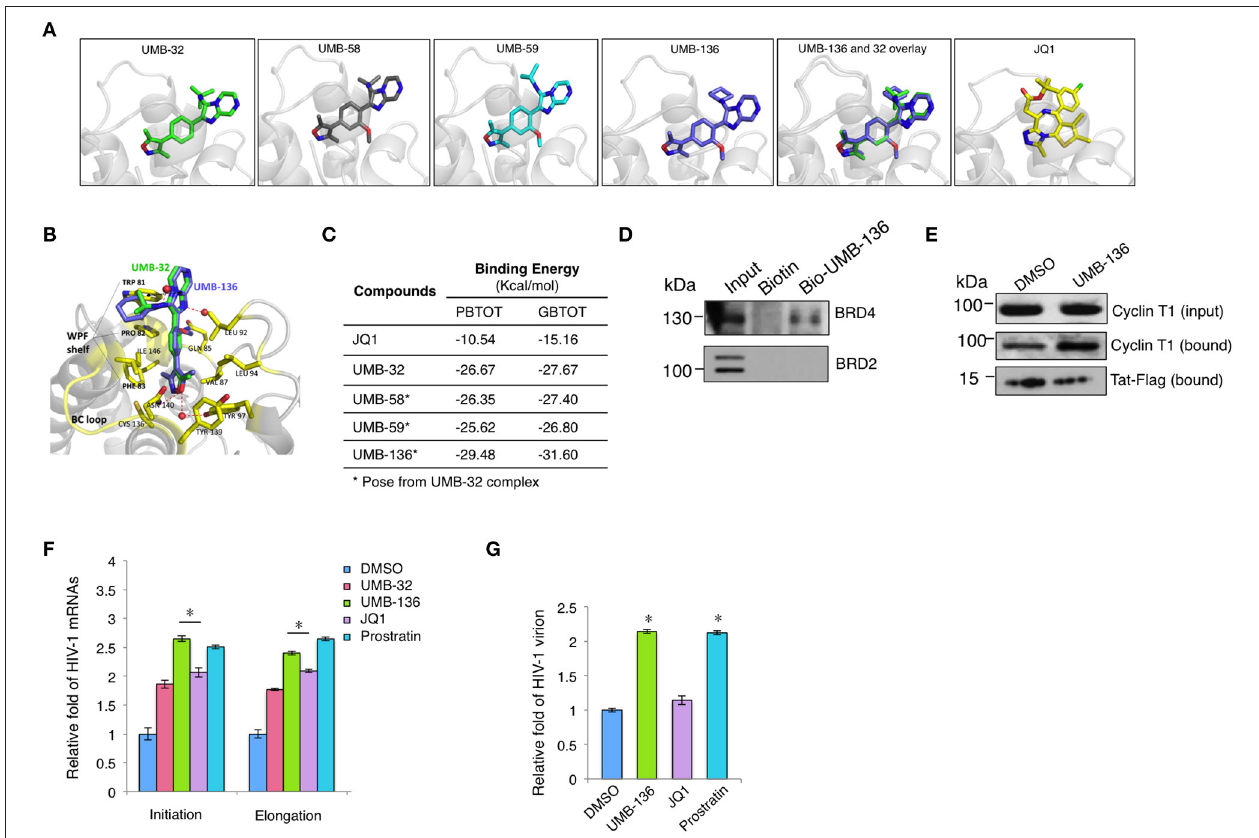
FIGURE 2 | UMB-136 promotes HIV-1replication by releasing P-TEFb through binding to BRD4. (A) The predicted binding of UMB-58, 59, and 136 with the BRD4 bromodomain (BD1) according to the available data for UMB-32. (B) The superimposition of UMB-136 (violet) onto UMB-32 (green) in complex of BRD4 BD1 (PDB ID: 4WIV; protein: residues in contact with ligand shown in yellow, the rest in gray); hydrogen bonding with crystal waters (red spheres) in dashed red lines, pi-stacking in black dashed line. Graphic representations of (A,B) are generated in PyMol Software. (C) Calculation of the binding energy (PBTOT—relative total binding energy using MM-PBSA; GBTOT—relative total binding energy using MM-GBSA) for UMB-32, 58, 59, 136, and JQ1. (D) Pull-down assay for UMB-136. The lysate of HEK293 cells was incubated with biotinylated UMB-136 or biotin in DMSO at 4 ◦ C for overnight with orbital rocking. MyOne TM Streptavidin T1 Dynabeads TM (Invitrogen) were added to the mixture for incubation for 2 h. Beads were washed and boiled to elute the precipitated proteins and subjected to immunoblotting using BRD4 or BRD2 antibody. (E) UMB-136 promotes the association of Tat and P-TEFb. Hela cells stably expressing Tat-Flag were treated with UMB-136 (2.5 µ M) or DMSO for 24 h, followed by the incubation with Magnetic Flag Conjugated beads (Clontch) at 4 ◦ C for overnight. Beads were washed and boiled to elute the precipitated proteins, which were subjected to immunoblotting using Cyclin T1 antibody. (D,E) were repeated twice individually. (F) Jurkat cells were infected with VSV-G pseudo-typed HIV-1 NL4-3 virus, and treated with UMB-32 (2.5 µ M), UMB-136 (2.5 µ M), JQ1 (1 µ M), prostratin (1 µ M), or DMSO. The level of viral transcripts at different length was determined by RT-qPCR using the indicated primers. (G) Jurkat cells were infected with full length NL4-3 (X4 tropic), and treated with UMB-136 (2.5 µ M), JQ1 (1 µ M), or prostratin (1 µ M). The newly produced viruses in the supernatant were measured by qPCR. Results were presented as mean ± s.e.m. of two or three biological replicates * p < 0.05, t-